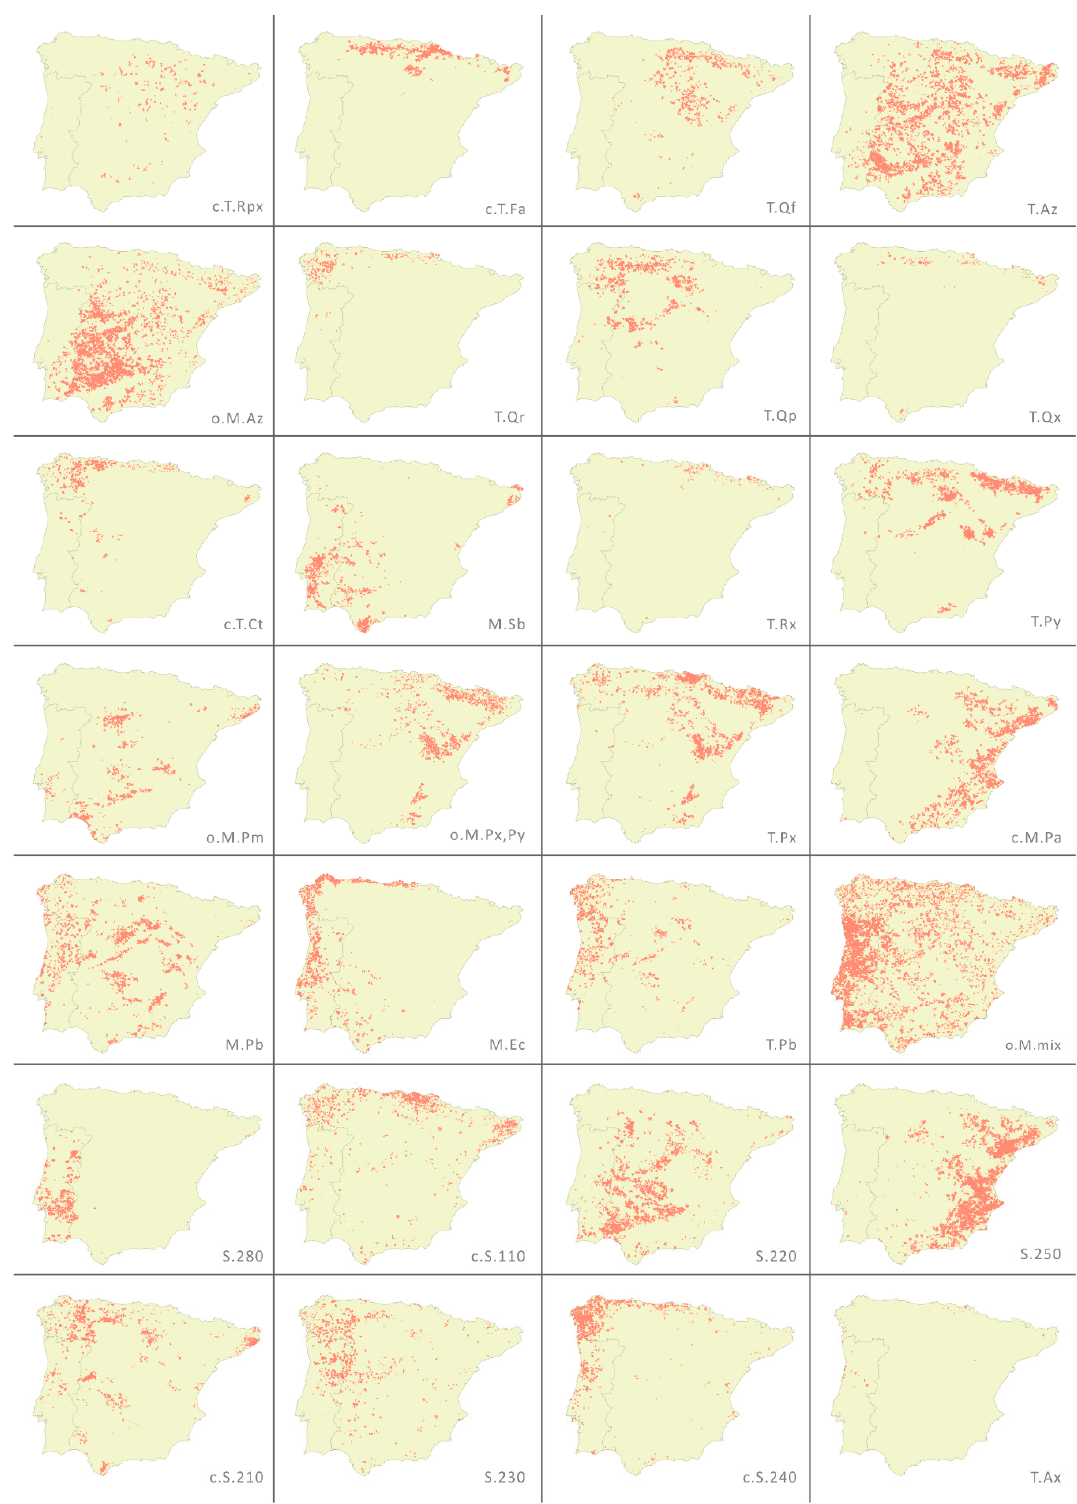
Figure 6. Distribution map of each forest type (1:50,000 scale).